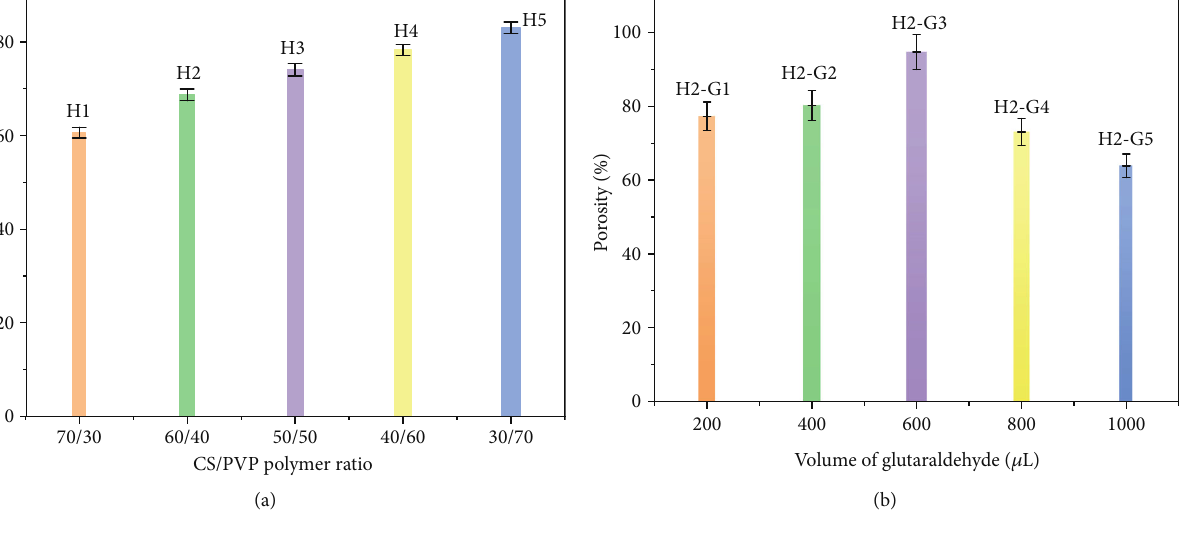
Figure 3: Porosity of hydrogel (a) H1 to H5 and (b) H2-G1 to H2-G5.